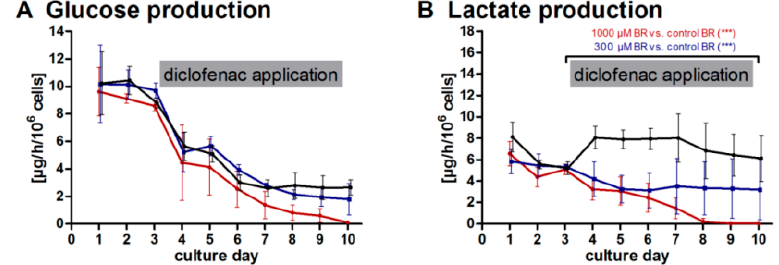
Figure 4. Cont. Figure 4.